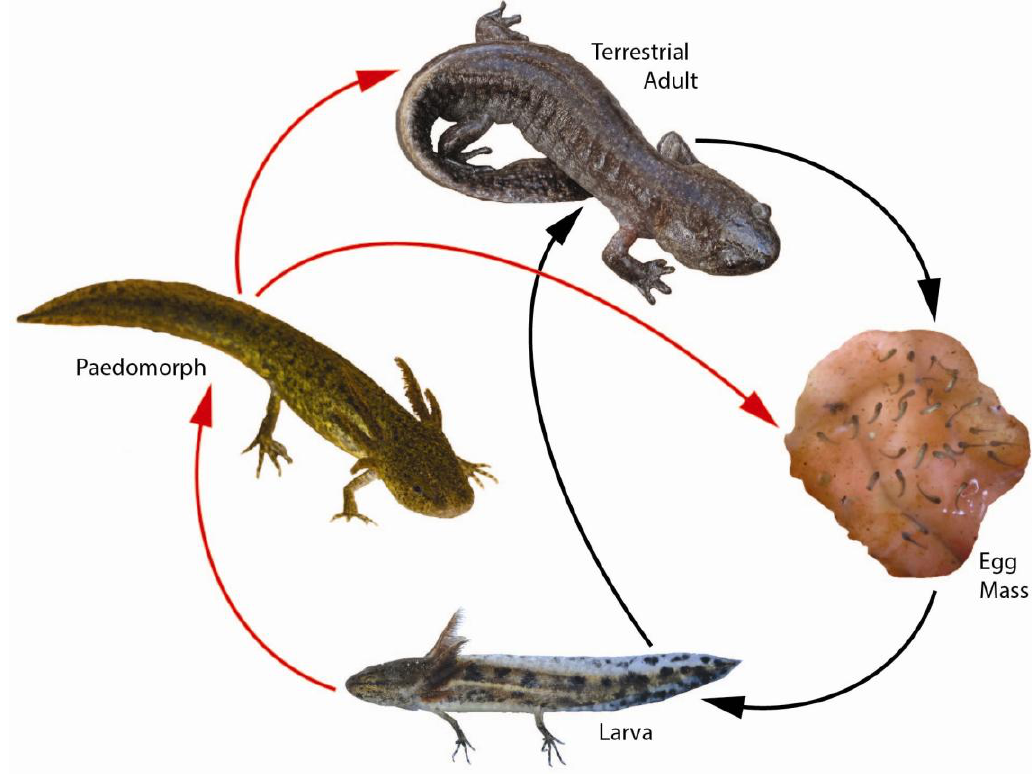
Figure 1. Complex life cycle [132] of the Mole Salamander, Ambystoma talpoideum . Black arrows indicate metamorphic pathway; red arrows indicate paedomorphic pathway. Except during breeding periods, metamorphosed adults occur in the terrestrial habitat; all other life stages are